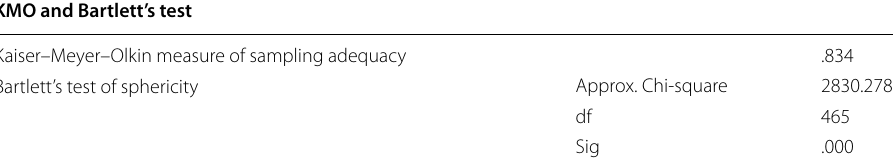
Table 2 Results of KMO and Bartlett’s test KMO and Bartlett’s